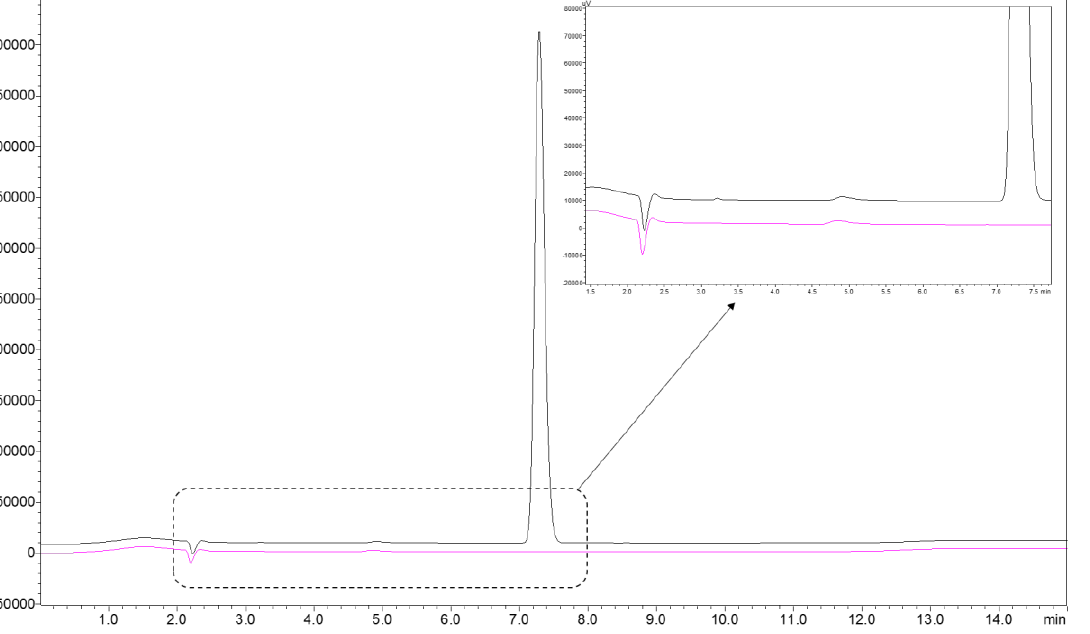
Table 5. Forced degradation results. BP: breakdown product.